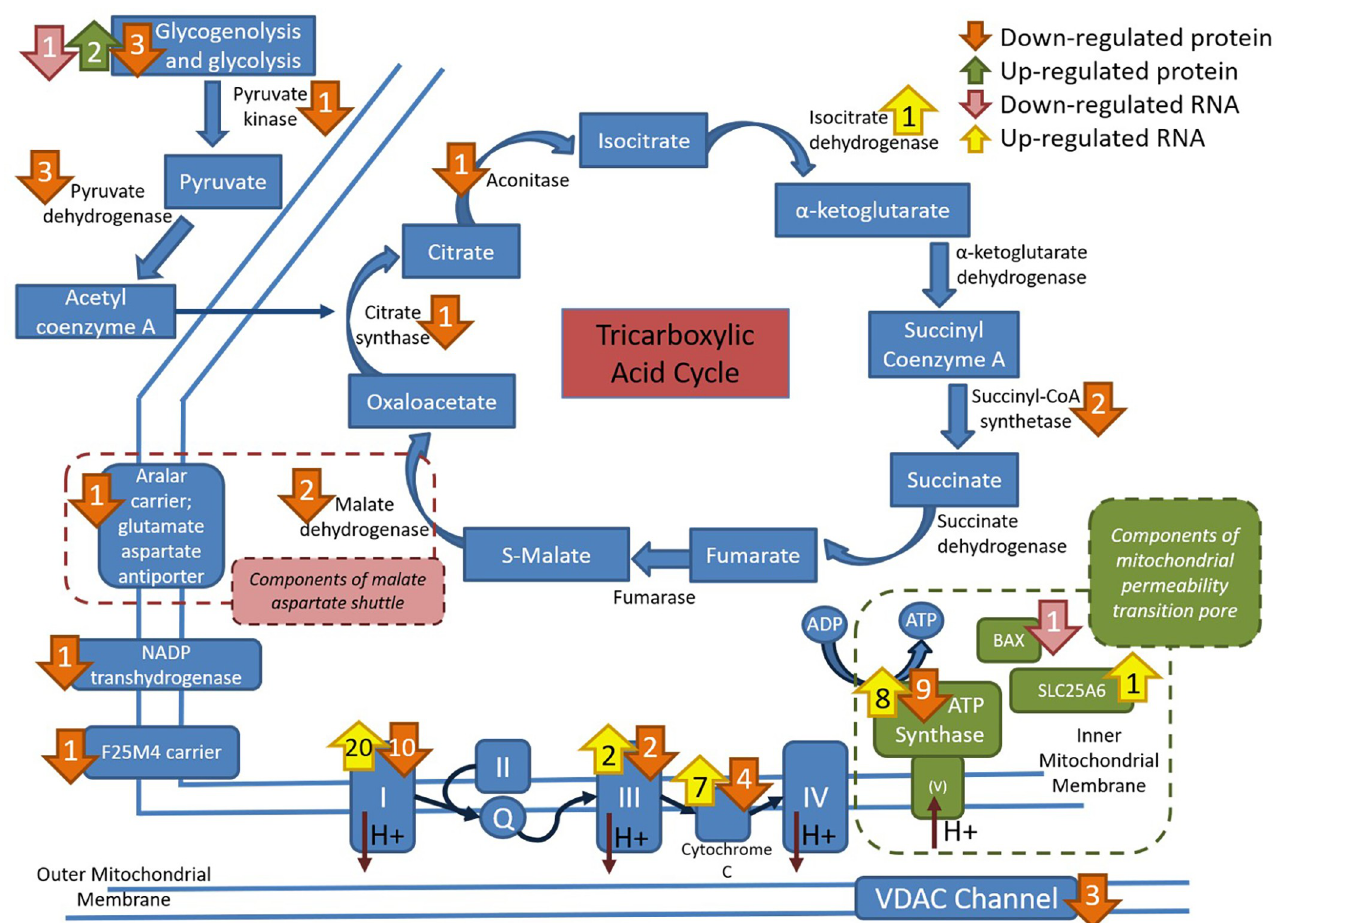
Fig 3. Depiction of the location of differentially expressed proteins and genes within the mitochondrial tricarboxylic acid cycle, electron transport system and mitochondrial Ca 2+ regulation. Increased expression is in green for protein and yellow for genes. Decreased expression is in orange for proteins and pink for genes. Note the strong impact of RER-susceptibility on the electron transfer system and channels related to Ca 2+ uptake ( VDAC ) or overload (mitochondrial permeability transition pore).